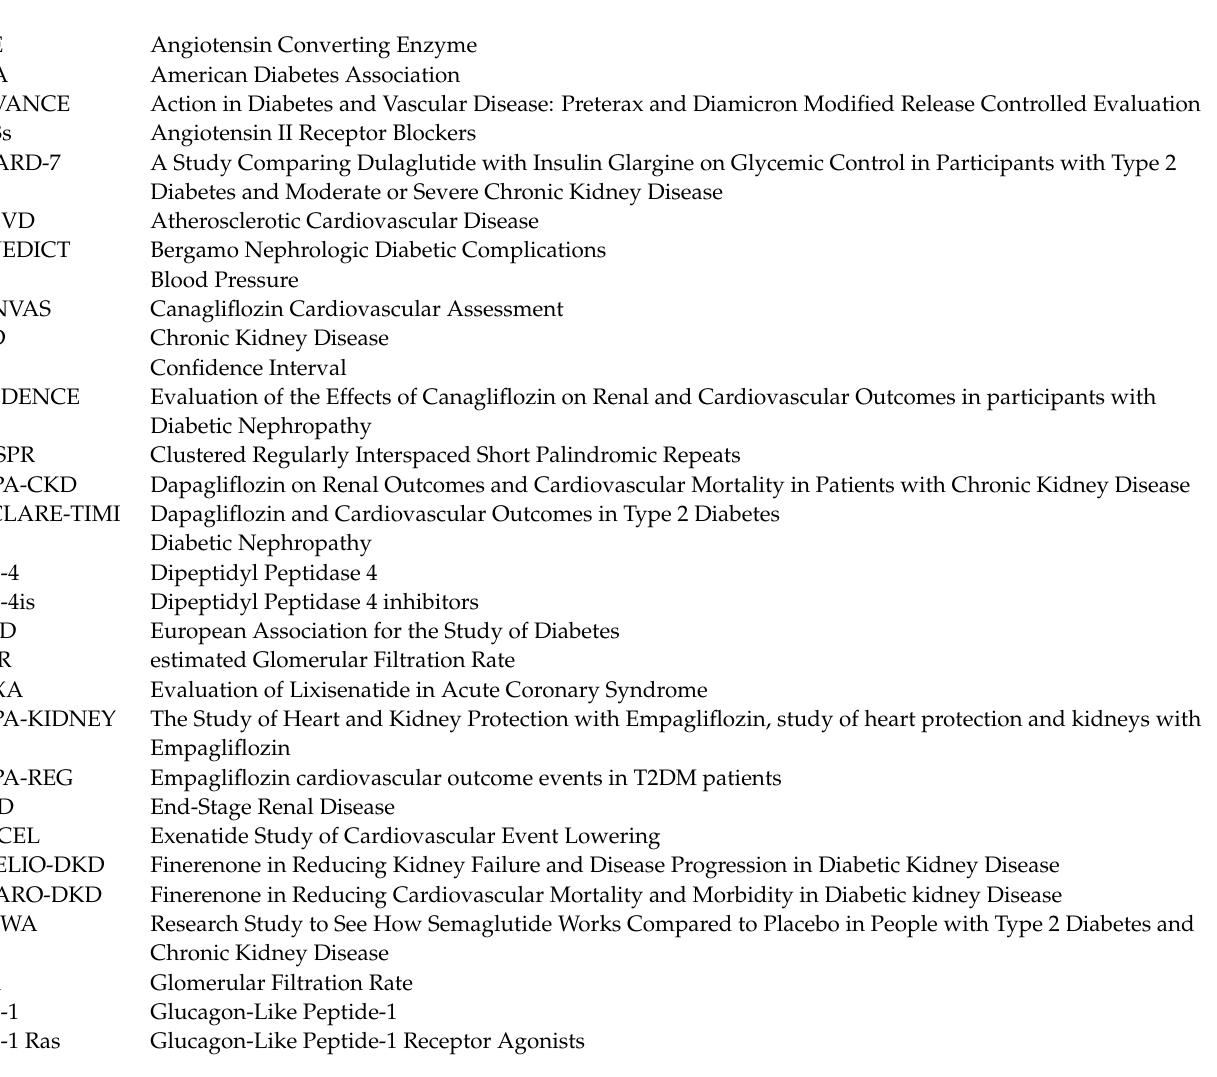
Finerenone in Reducing Cardiovascular Mortality and Morbidity in Diabetic kidney Disease FLOWA Research Study to See How Semaglutide Works Compared to Placebo in People with Type 2 Diabetes